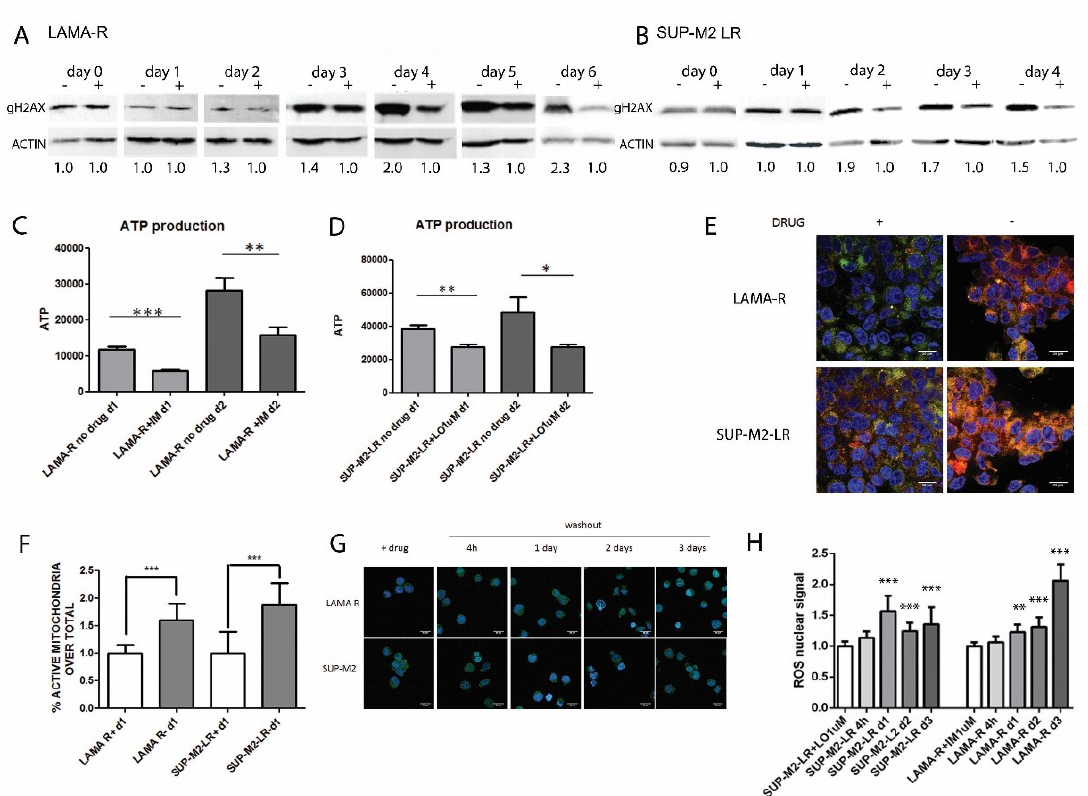
Figure 3. Drug withdrawal in drug addicted cells enhance mithocondria activity and reactive oxygen species (ROS) production, ending up in genotoxic stress. ( A ) The genotoxic marker γ H2AX was detected in LAMA-R and ( B ) SUP-M2-LR at the indicated time points upon drug withdrawal respectively. β –ACTIN was used as loading control. For each panel at least two independent experiments were performed. Lorlatinib and Imatinib were always added to the medium at 1μM. Densitometric analysis normalized on the ON DRUG condition is shown ( C ) ATP production in LAMA-R cell lines or ( D ) SUP-M2-LR was evaluated 1 or 2 days upon drug withdrawal. ( E ) Mithocondria activation increases upon drug withdrawal. The drug, imatinib for LAMA-R and lorlatinib for SUP-M2-LR cell lines, was removed from medium and after 24 h cells were harvested, labelled with Mitotracker and detected at confocal microscopy. BLUE = DAPI. GREEN = total mithocondria. RED = active mithocondria fraction. Scale bar: 20 μM. A representative panel is shown ( F ) The histogram represents the average of two independent experiment each cell line with Mitotracker. ( G ) ROS production is increased after 1 to 3 days upon drug withdrawal. The drug was removed from medium and after 4 h, 1 day, 2 days or 3 days. Cells were stained with CellROX® Green Reagent and signal was detected with confocal microscopy. Scale bar: 20 μM. A representative panel is shown. ( H ) The histogram represents the average of two independent experiments performed with CellROX® Green Reagent. * p < 0.05, ** p between 0.05 and 0.01 *** p < 0.01. + and − indicate the presence or the absence of the drug.